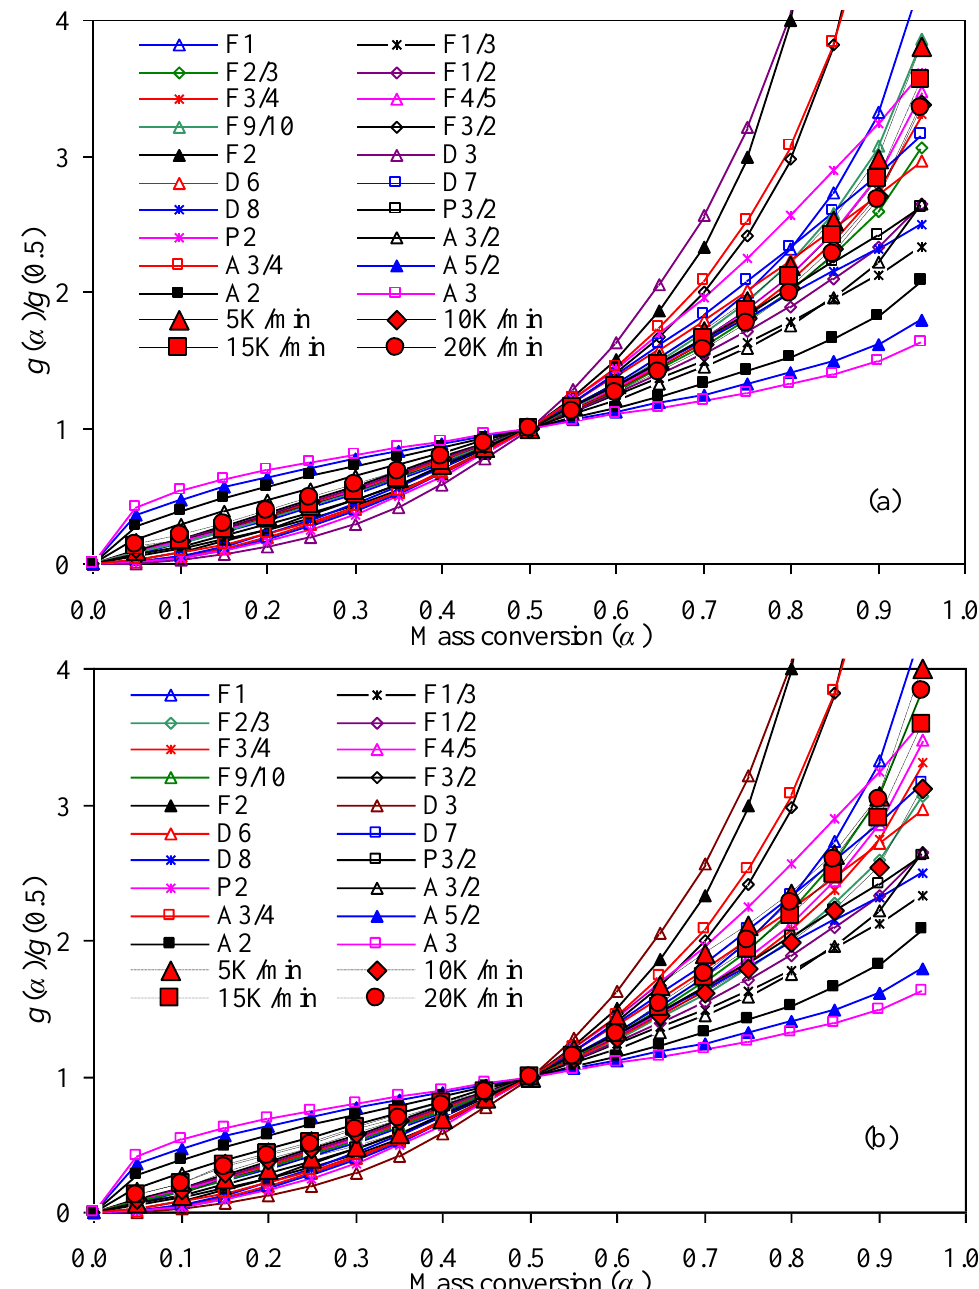
Figure 6. Theoretical and experimental G-master plots for nylon-6 string waste samples: ( a ) in N 2 and ( b ) in air.